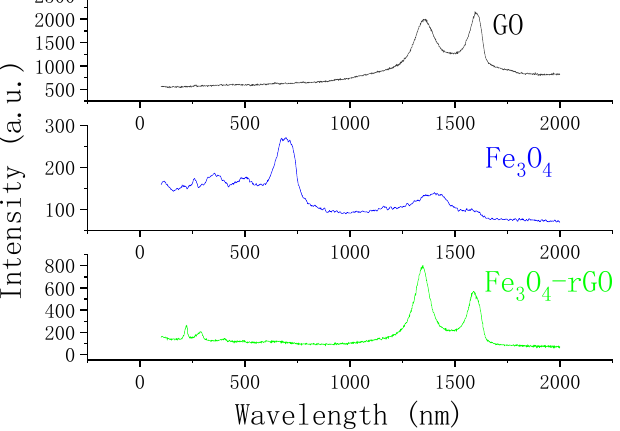
Figure 3. Raman spectroscopy results of GO, Fe 3 O 4 , and Fe 3 O 4 –rGO. As shown in Figure 4, the FTIR images of GO and Fe 3 O 4 –rGO reveal the relevant functional groups. In the FTIR image of GO, the peak at 3500 cm − 1 is -OH, that at 1629 cm − 1 is the stretching mode of the sp 2 C network in the aromatic ring, that at 1383 cm − 1 is O=C-O, and that at 1164 cm − 1 is C-OH. In the image for Fe 3 O 4 –rGO, the peak at 617 cm − 1 is the characteristic peak of Fe 3 O 4 , while at the -OH peak, compared with that for GO, the band is wider and the peak intensity is also reduced [24,25].